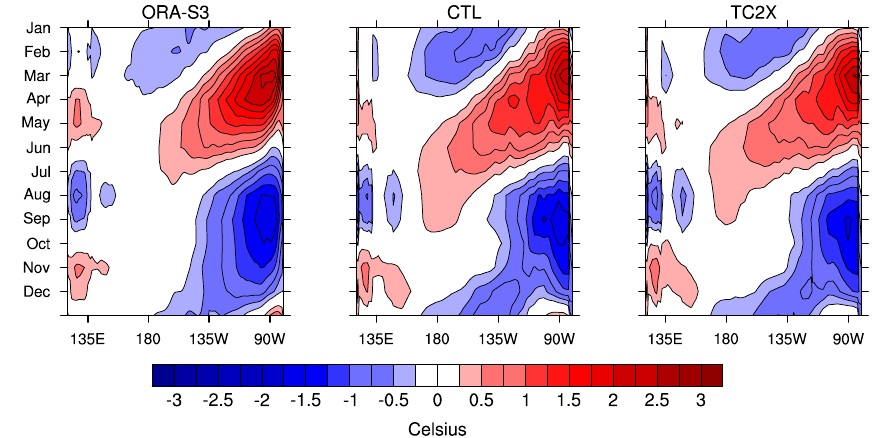
Fig. 6. Longitude-time plots of the annual cycle of sea surface temperature anomalies in the equatorial Pacific (between − 5 and 5 ◦ N) relative to the long-term mean, for (A) European Centre for Medium-Range Weather Forecasts (ECMWF) Ocean Re-Analysis (ORA-S3) product (Balmaseda et al., 2008), (B) the CCSM control simulation with the standard atmospheric forcing, and (C) the CCSM simulation with TC winds scaled by 2X. The annual cycle is calculated over the period 1960–2009 for ORA-S3 and over the 7yr of model cycle for the CCSM simulations, reflecting large-scale atmospheric forcing conditions corresponding to 1994–2000.